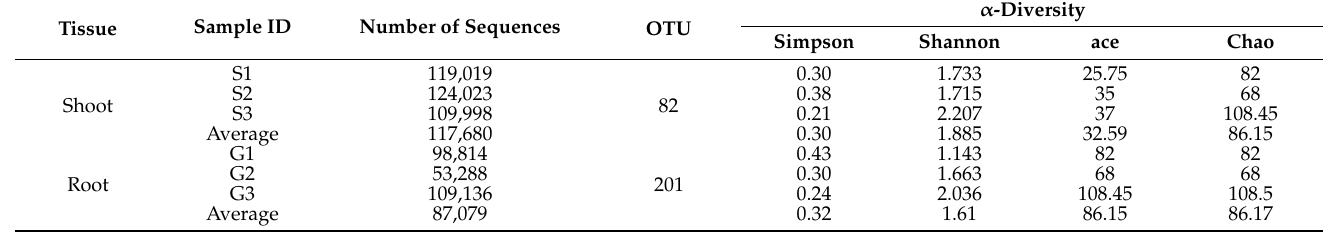
Table 4. The number of OTUs and alpha-diversity indices of culture-independent endophytic fungi of S. chamaejasme (distance < 0.03).